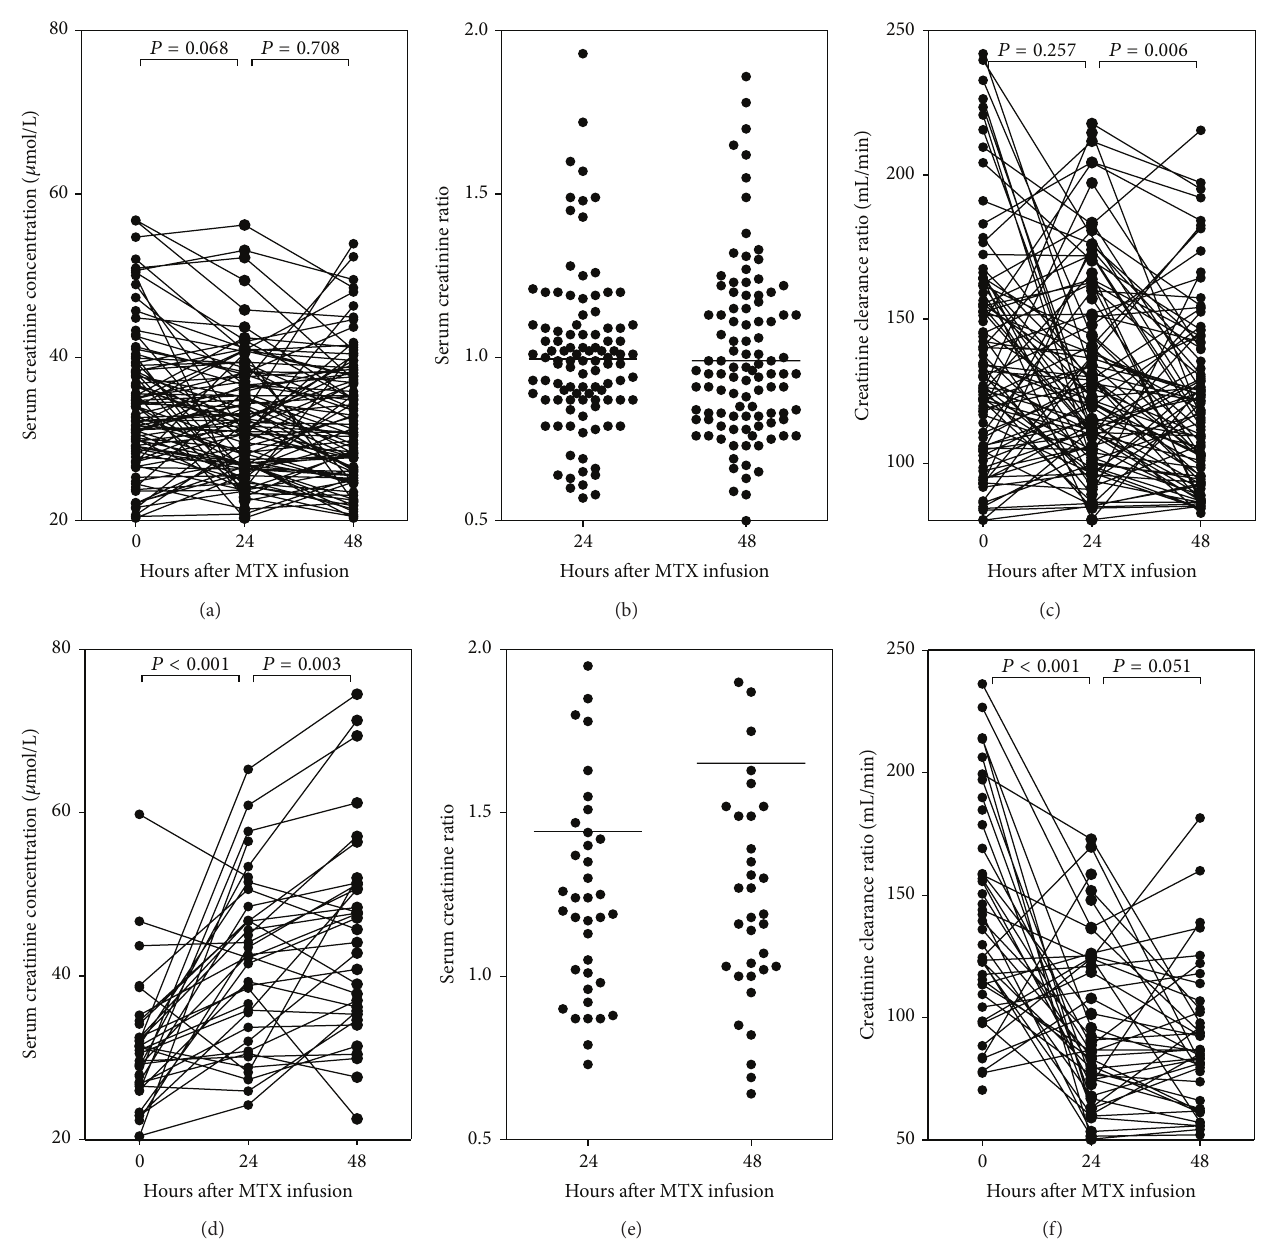
Figure 2: Comparison of renal function in normal and delayed MTX elimination. In normal MTX elimination patients, serum creatinine concentration (a) and creatinine ratio (b) were comparable while the CCR was slightly decreased 24 hours after MTX infusion (c). In delayed MTX elimination patients, serum creatinine concentration (d) and creatinine ratio (e) were gradually increased while CCR was decreased